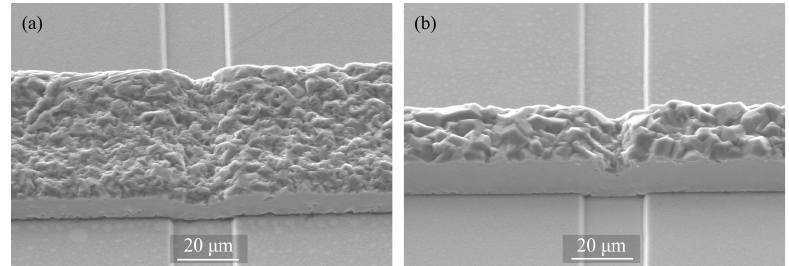
Figure 13. SEM images of the pattern-deposited films on a 2 µm–depth trenched substrate with ( a ) 50 µm and ( b ) 20 µm frame width obtained at 20 mA/cm 2